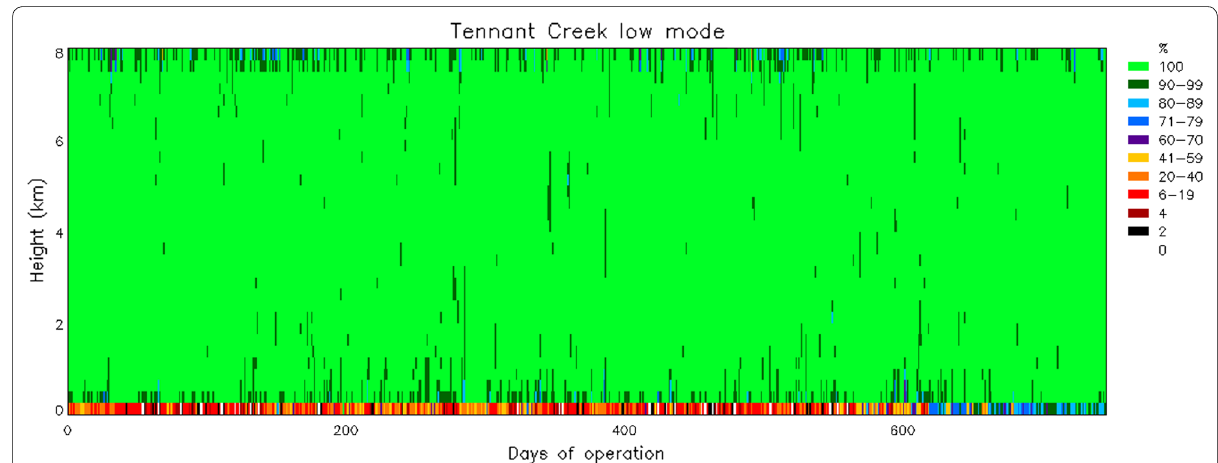
Fig. 5 Tennant Creek low - mode daily 90% acceptance summary plot. The x axis shows days beginning from 13 December 2011